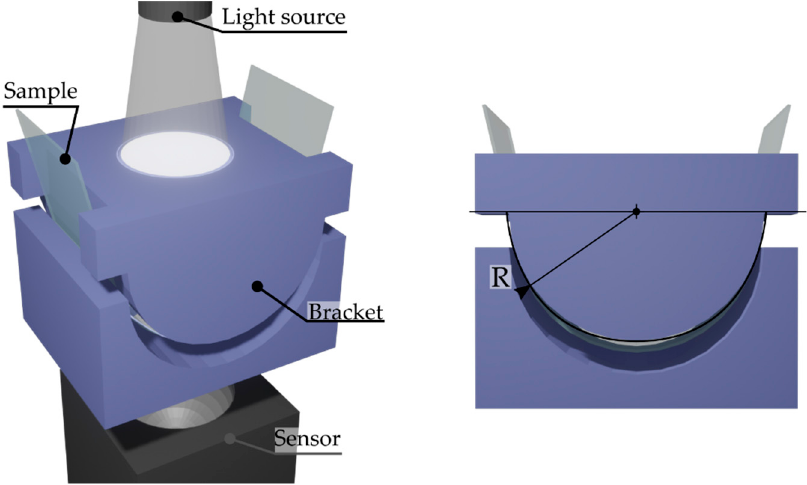
Figure 2. Schematic representation of the experimental setup employed to measure the different strained